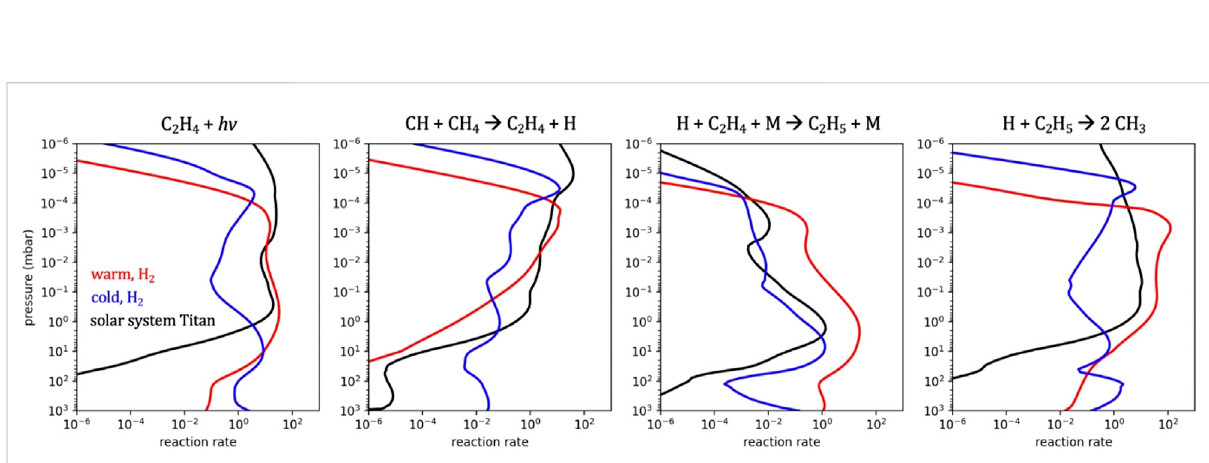
FIGURE 11 Rates (cm − 3 · s − 1 ) of dominant production and loss reactions for C 2 H 4 . Black lines represent a cold N 2 atmosphere (Titan), blue lines represent a cold H 2 atmosphere, and red lines represent a warm H 2